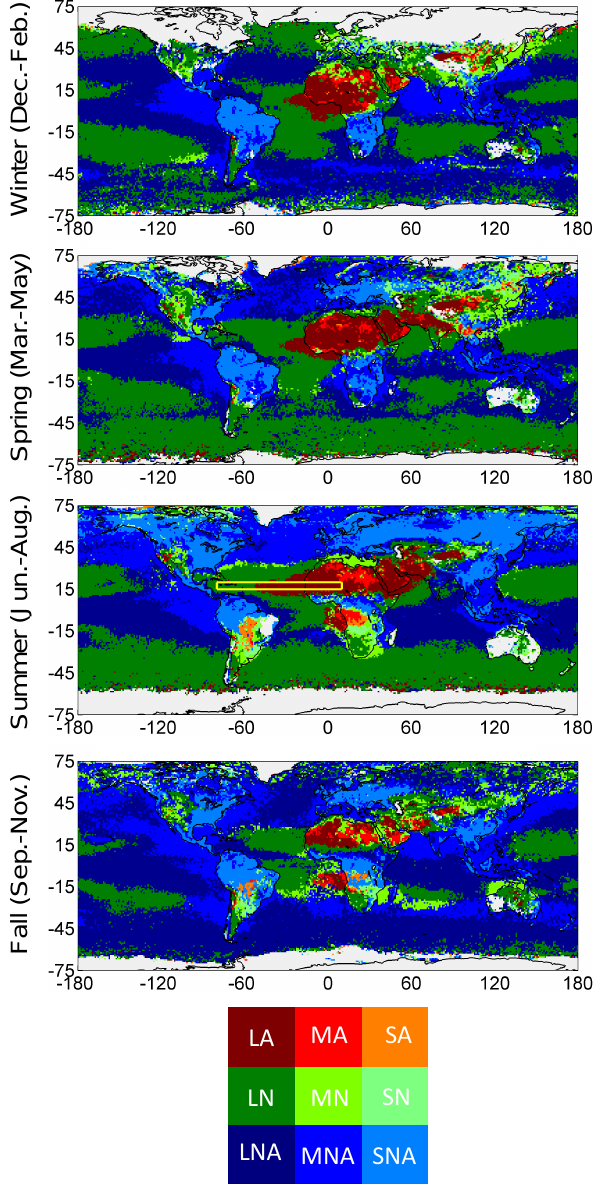
Figure 4. Seasonal cycle of global aerosol type distribution accord- ing to GACA. Data are from 2007–2011 and were divided into the four main seasons (from top to bottom): winter, spring, summer, and fall. The legend is given on the bottom; see Fig. 1 and Table 2 for aerosol-type abbreviations. The yellow box indicates the region investigated in Fig. 5.